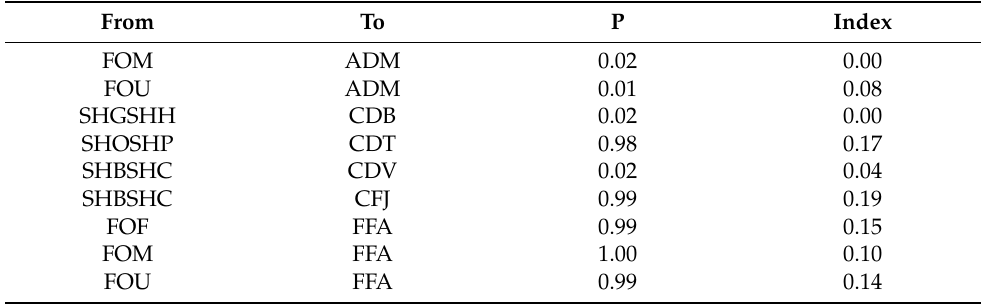
Table A7. Preferred associations from foster-reared chicks to all other flamingos within the network.